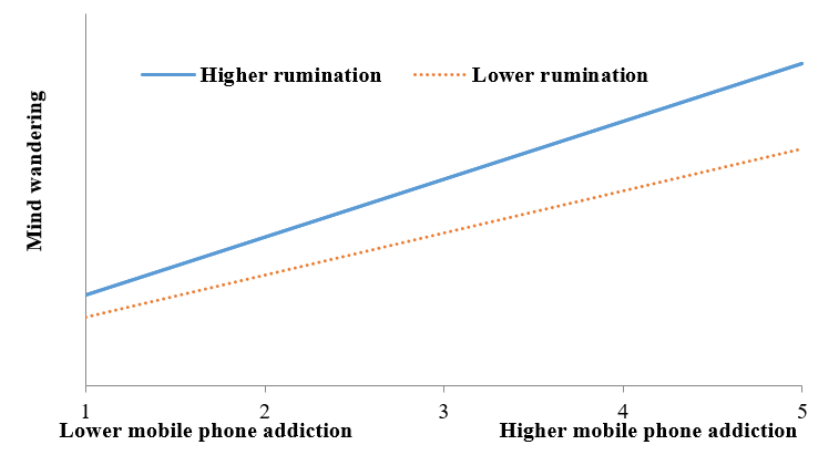
Figure 3. Rumination moderates the relationship between mobile phone addiction and mind wan- dering.